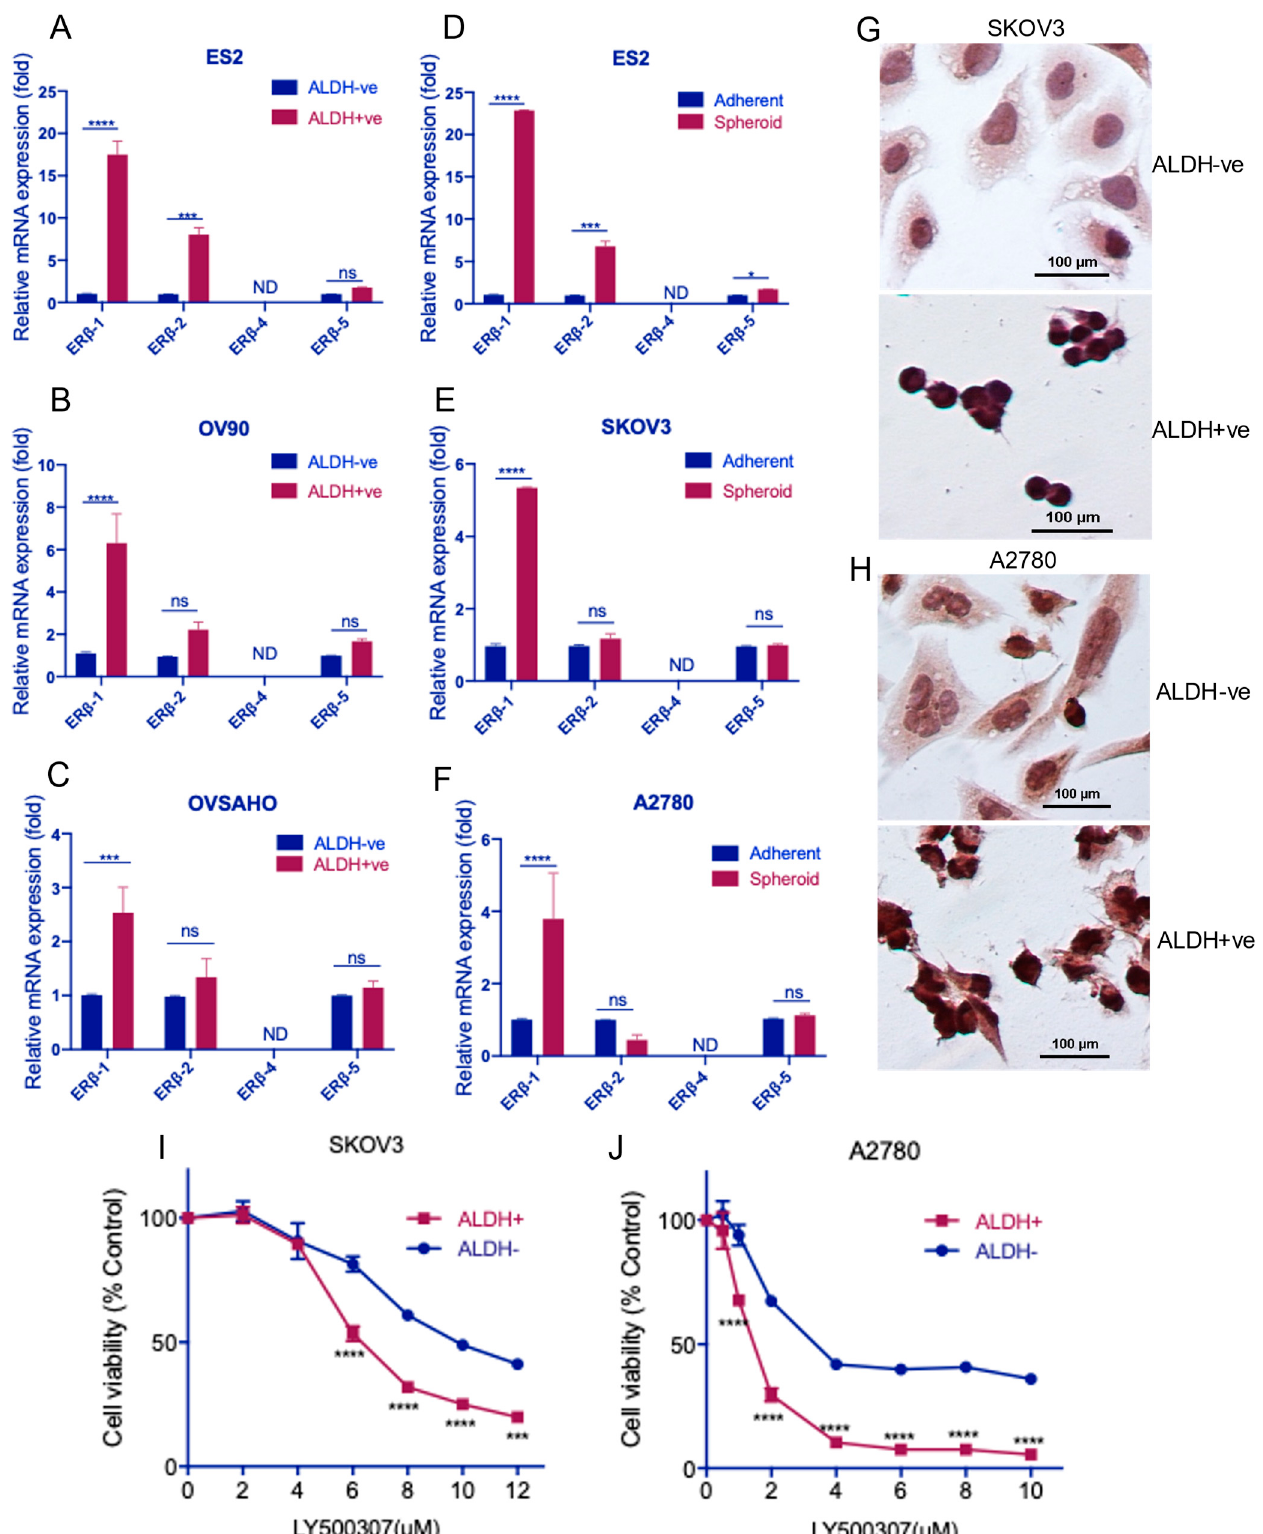
Figure 1. ER β is highly expressed in OCSCs. ( A – C ) , ES2, OV90, and OVSAHO cells were subjected to ALDEFLUOR assay and the expression of ER β isoforms 1, 2, 4, and 5 in ALDH-ve and ALDH+ve cells was determined using RT-qPCR. ( D – F ), SKOV3, ES2, and A2780 cells were cultured as adherent (2D) and spheroid (3D) cultures and the expression of ER β isoforms 1, 2, 4, and 5 was determined using RT-qPCR. ( G , H ), ALDH-ve and ALDH+ve cells enriched from SKOV3 and A2780 cells were